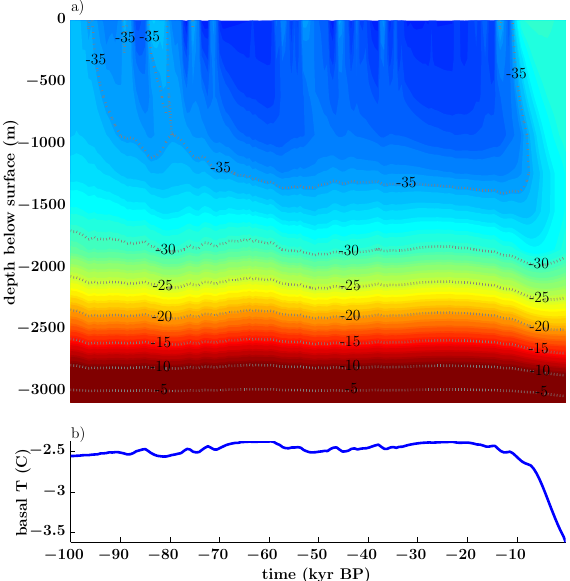
Figure 5. (a) Temperature evolution through time of the simulated ice column at the location of the observed GIS summit; (b) basal temperature